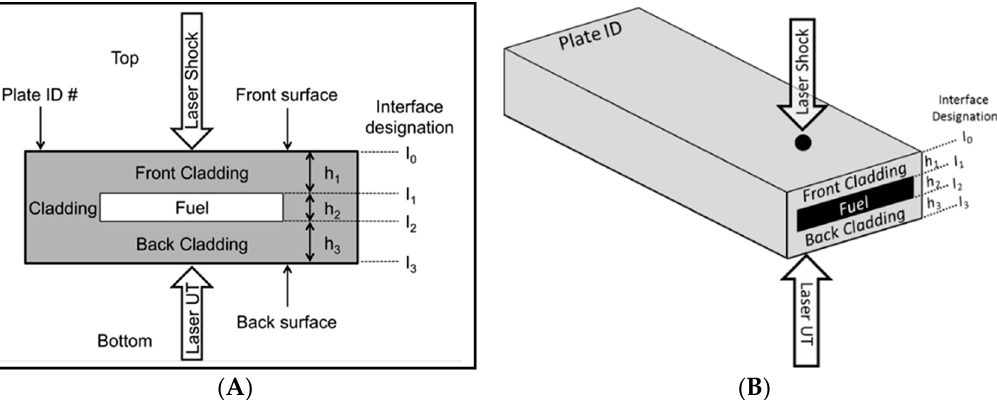
Figure 6. Diagrams showing the plate geometry and nomenclature used for laser shock testing. ( A ) is the cross-sectional figure, and ( B ) shows the experimental geometry.